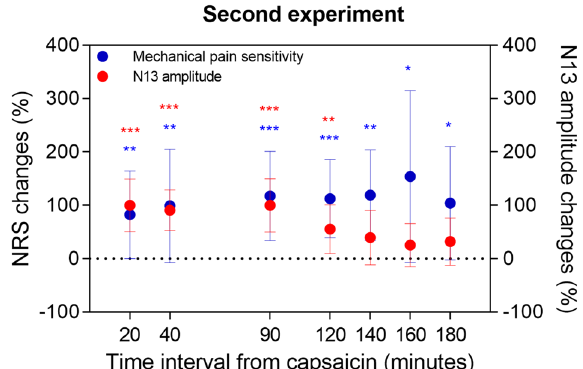
Figure 2. Experiment 2: Time course of capsaicin-induced modulation of N13 somatosensory evoked potentials (SEPs). Red dots: N13 amplitude changes (at each interval N13 SEP amplitude was normalized to baseline amplitude); blue dots: secondary hyperalgesia rating (at each interval the magnitude of mechanical pain sensitivity was normalized to baseline magnitude as assessed by a 0–100 numerical rating scale). Dots represent mean and standard deviations. Asterisks indicate significance vs. baseline (Dunnett’s corrected p-value), *p < 0.05, **p < 0.01, ***p <